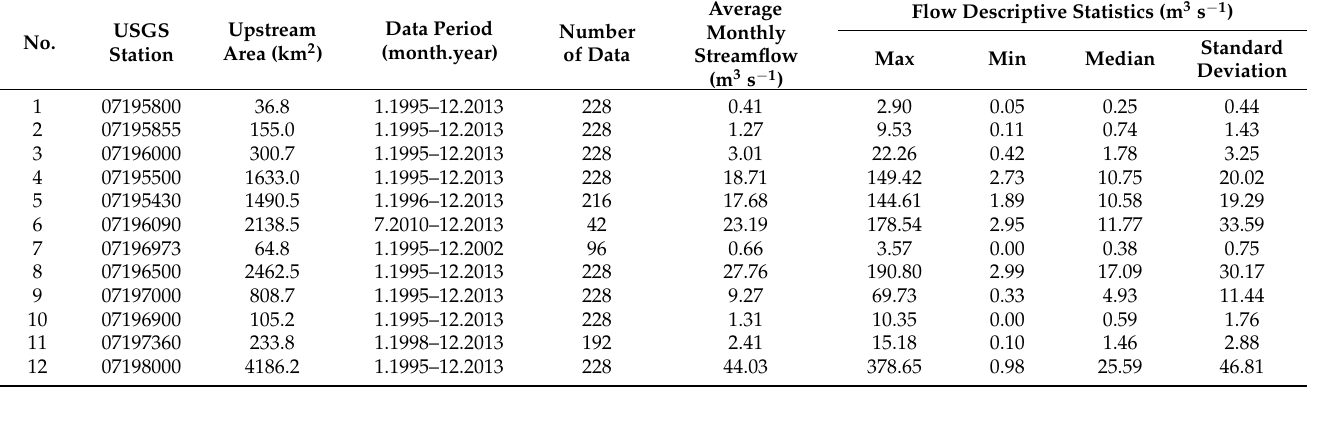
Table 1. Watershed properties and selected descriptive statistics of USGS hydrological stations.